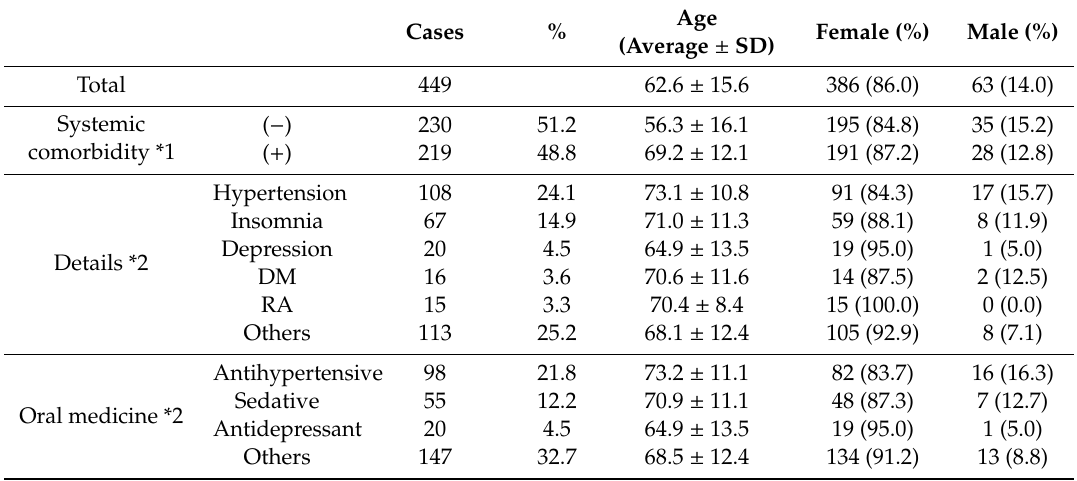
Table 2. Prevalence of systemic comorbidities and oral medicine